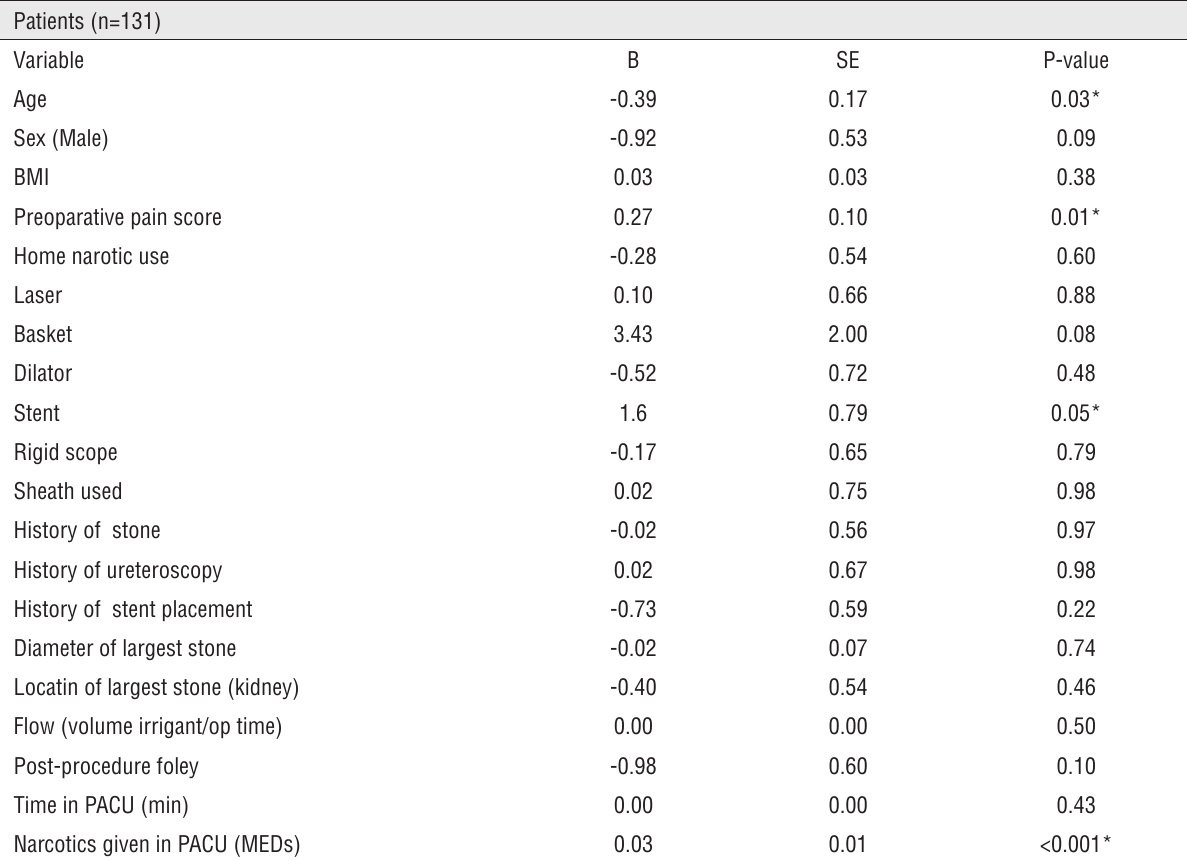
Table 3 - Linear Regression for Predictors of Post-Ureteroscopy Pain. Patients